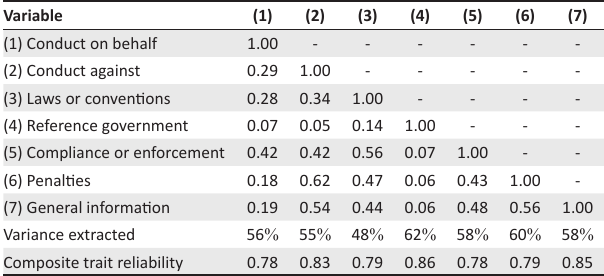
TABLE 4: Measurement model – Goodness-of-fit measures. CMIN DF CMIN, chi-square value; DF, degrees of freedom; P, calculated probability; CMIN/DF, normed chi-square; NFI, normed fit index; IFI, Bollen’s incremental fit index; CFI, comparative fit index; RMSEA, is root mean square residual. TABLE 5: Squared inter-construct correlations and summary statistics.